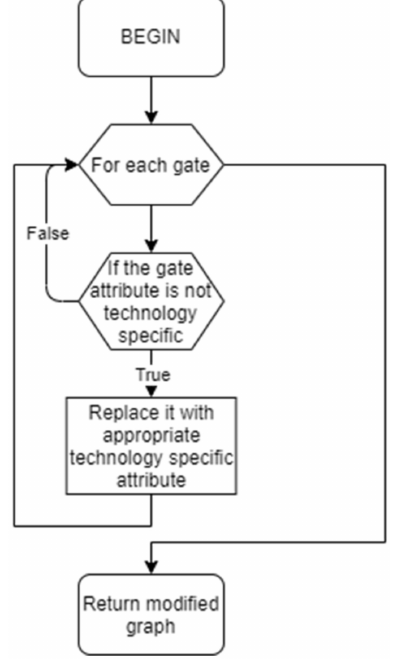
Figure 9. Technology gate mapping.